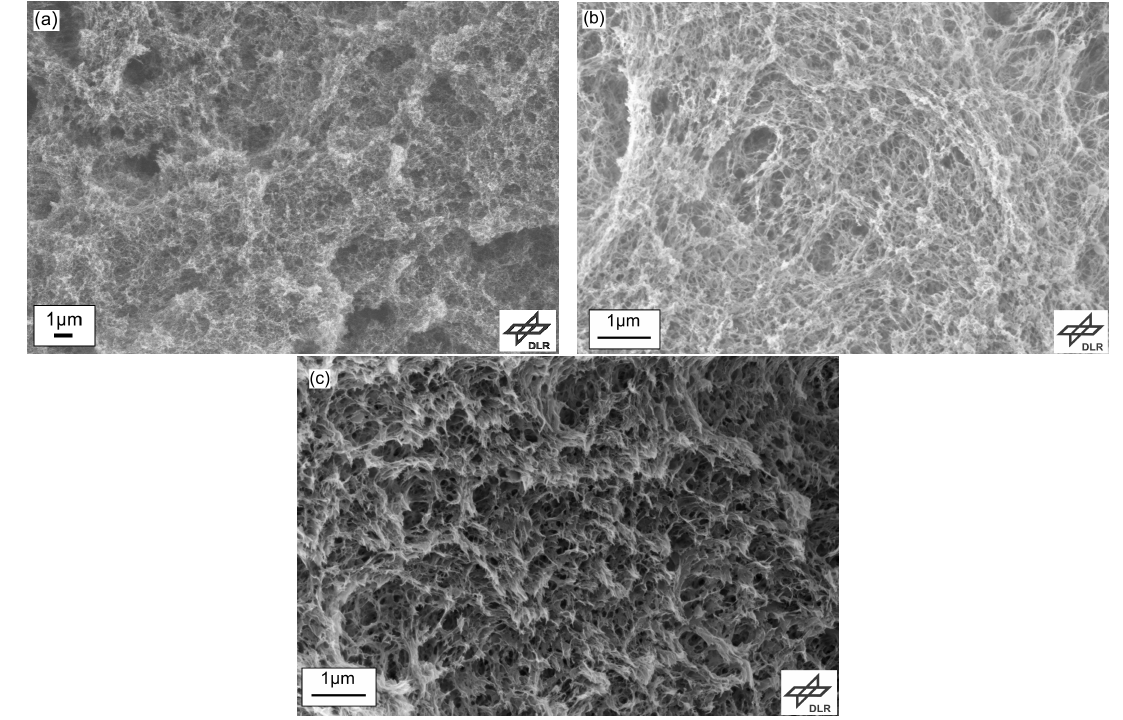
Figure 3. SEM images of cellulose aerogels with ( a ) 3 wt. %, ( b ) 5 wt. %, ( c ) 7 wt. % cellulose concentration.